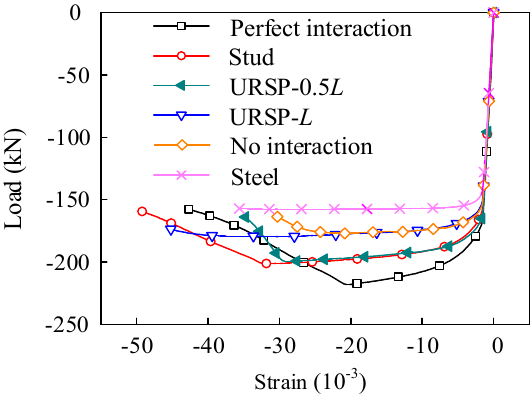
Figure 10. Load-strain curves of the bottom flange.